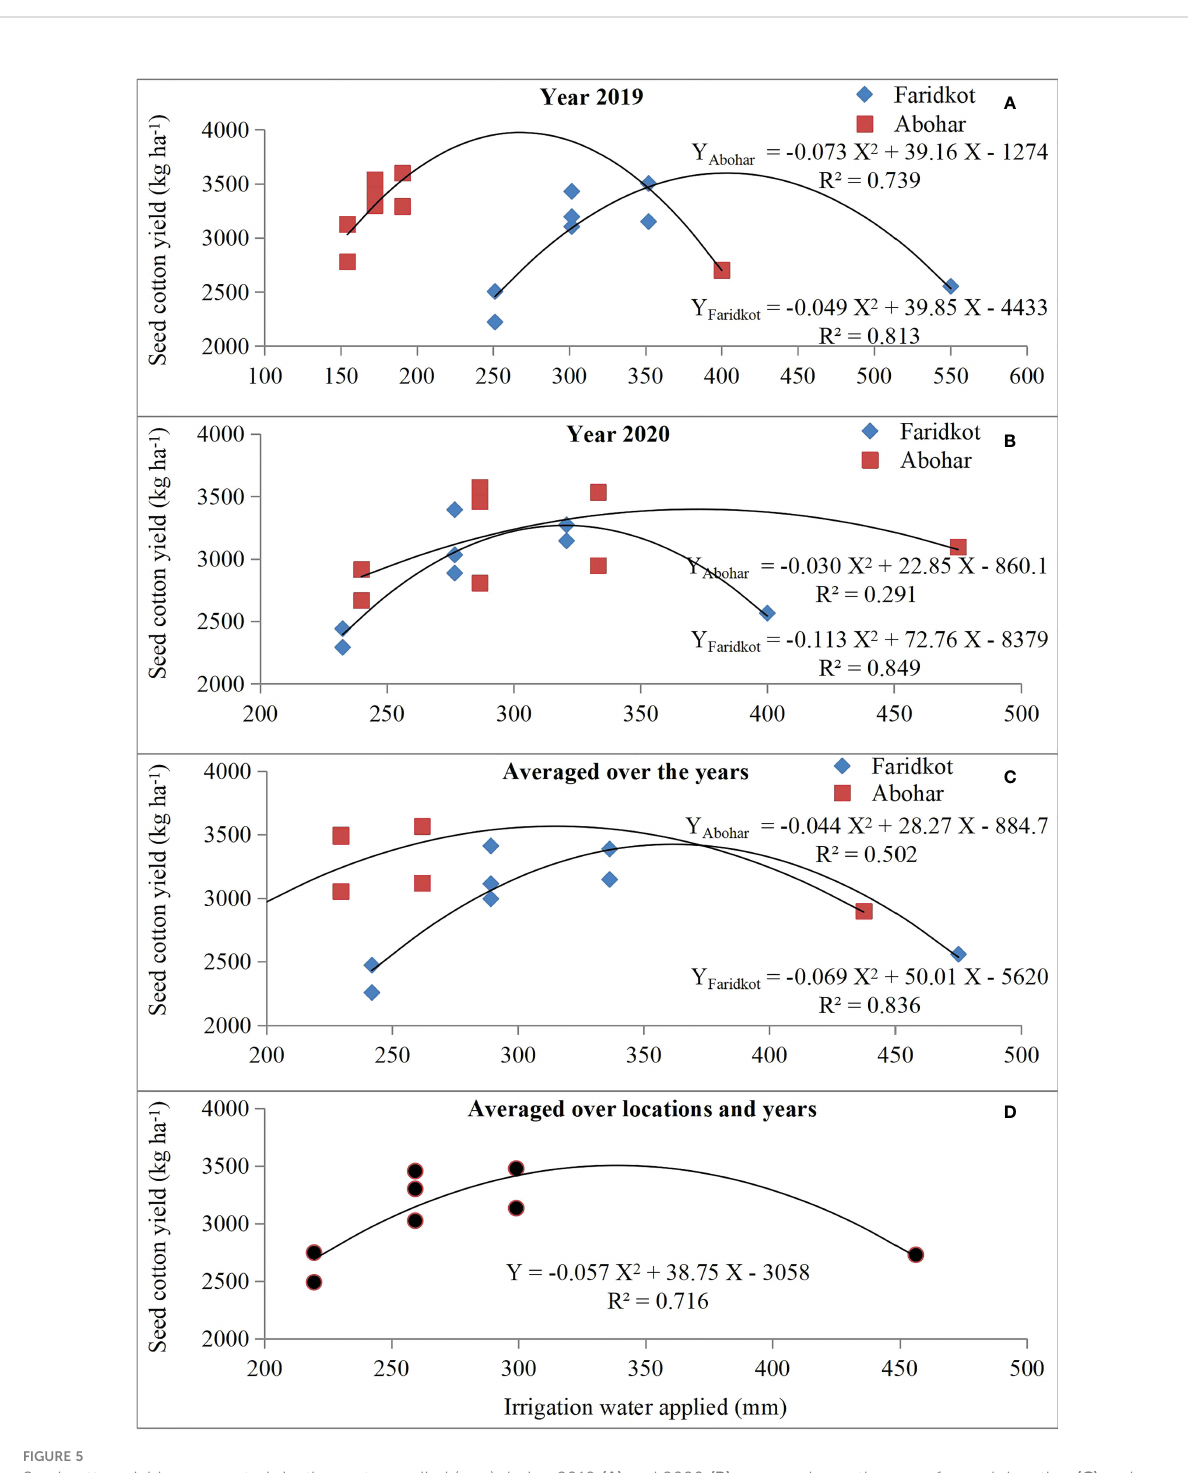
FIGURE 5 Seed cotton yield response to irrigation water applied (mm) during 2019 (A) and 2020 (B) , averaged over the years for each location (C) and averaged over the locations and years (D)